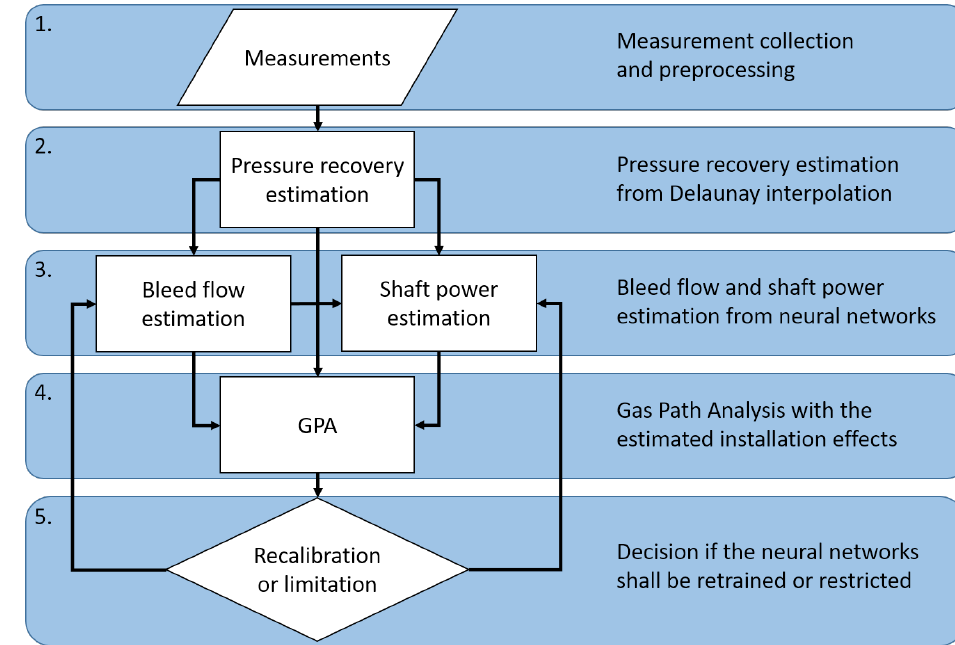
Figure 8. Diagnostic principle flowchart.